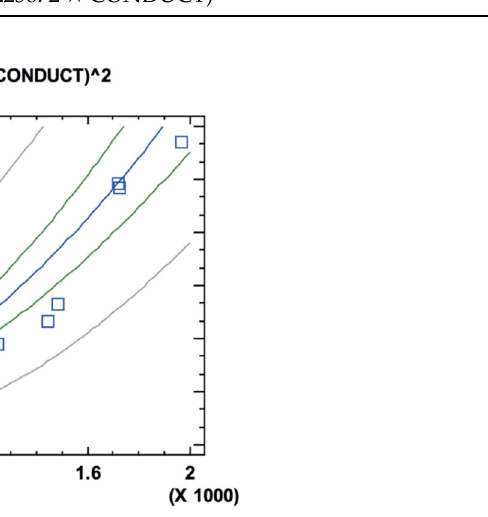
Figure 9. Graph of the model adjusted to determine the effect of the conductivity of the water with the concentration of manganese